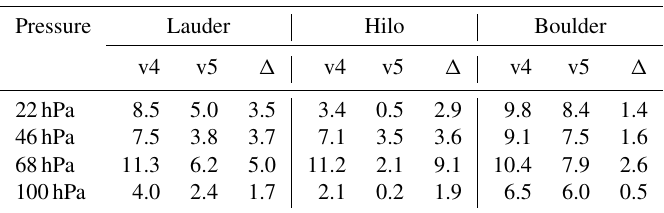
Figure 14. Drifts between MLS water vapor (v5, red, and v4, blue) and ACE-FTS version 4.1 observations. Coincidence criteria (and v4 results) are the same as for Fig. 2, with error bars on v4 omitted here for clarity. Table 2. Comparison of MLS v4 and v5 water vapor drifts versus the frost point record. All numbers (apart from those for pressure) are percent per decade. Differences ( (cid:49) ) are v4 minus